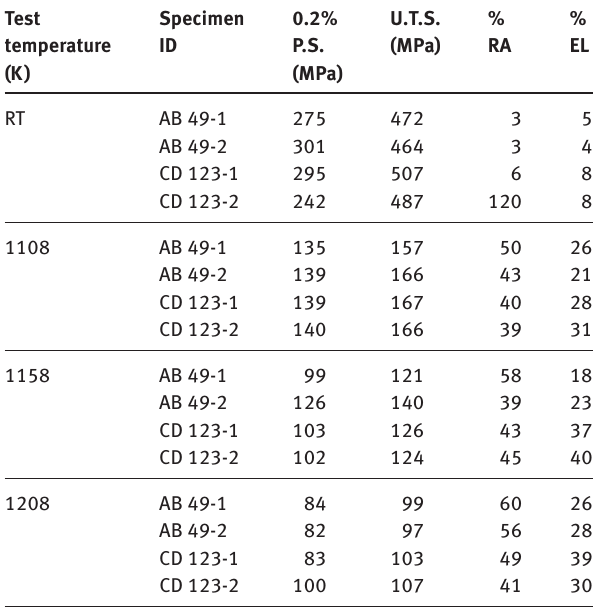
Table 9 reproduces compositions of sigma phases in